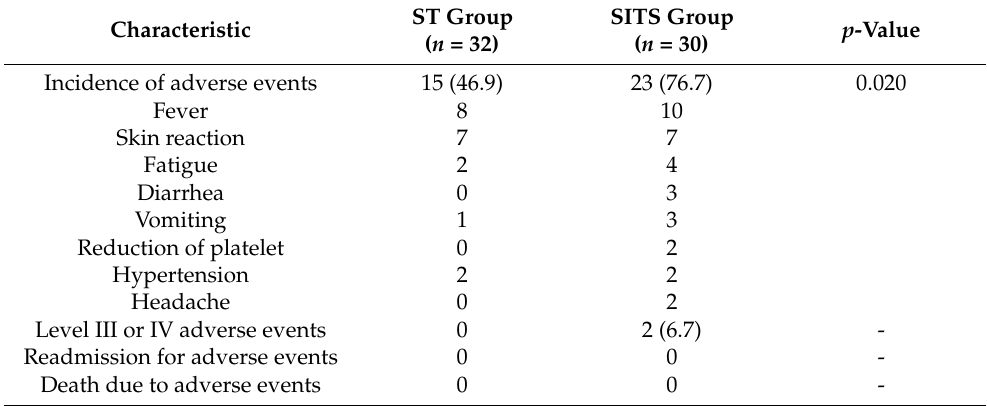
Table 5. Adverse Table 5. Adverse events.